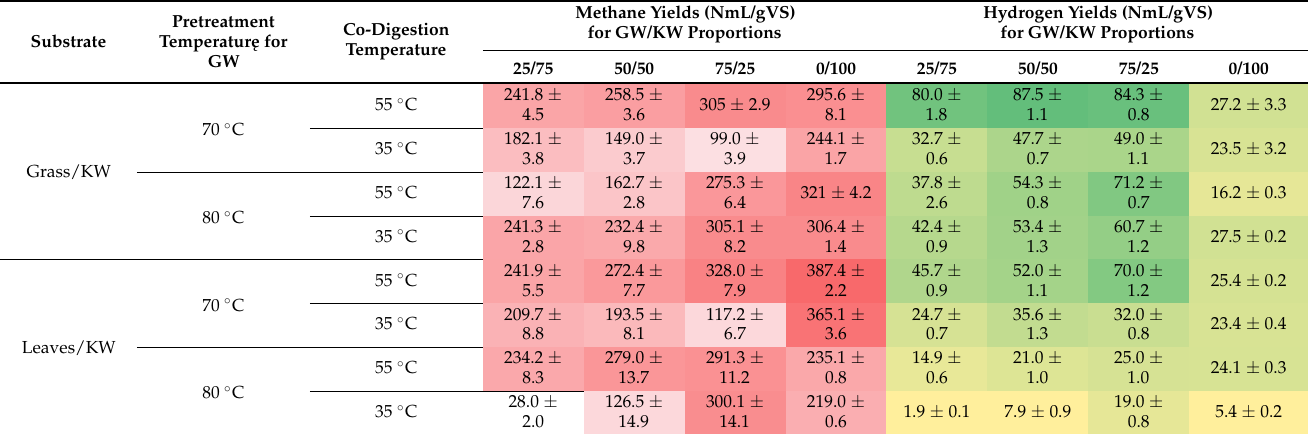
Table 3. Total methane and hydrogen yields in the second-stage co-digestion